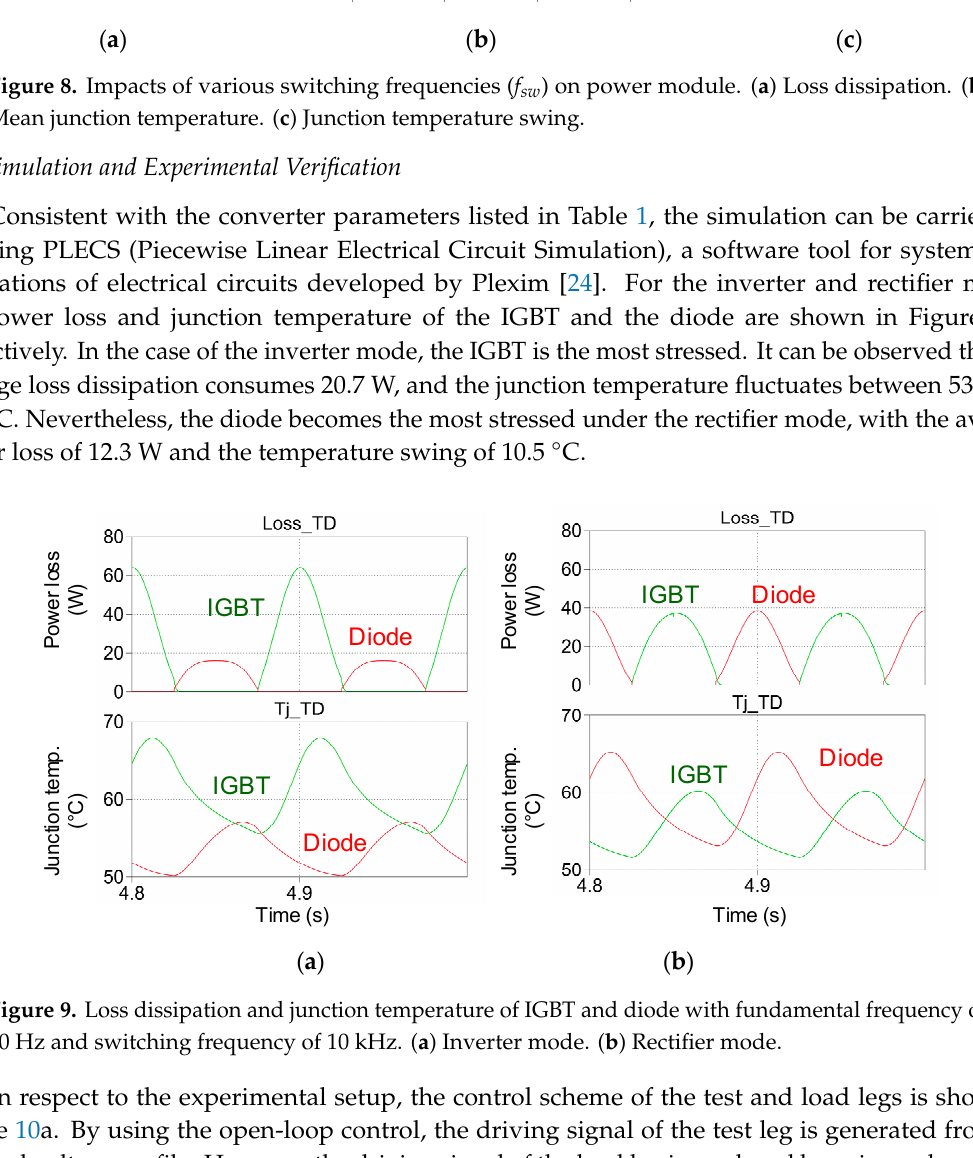
of 10 Hz and switching frequency of 10 kHz. ( a ) Inverter mode. ( b ) Rectifier mode.